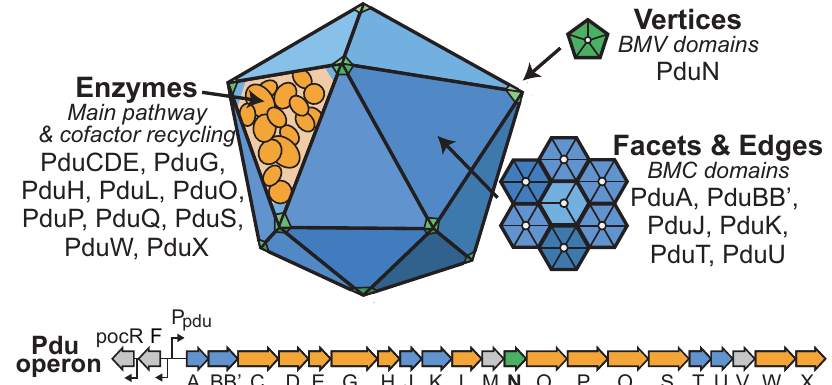
Fig. 1 The 1,2-propanediol utilization microcompartment from Salmonella is made up of proteins encoded by the pdu operon. The pdu operon in Salmonella enterica serovar Typhimurium LT2 contains the genes encoding proteins responsible for formation of the 1,2-propanediol utilization microcompartment (Pdu MCP). These include enzymes that perform both key pathway steps and cofactor recycling functions (orange) and shell proteins that encase these enzymes (bacterial microcompartment, BMC, domain-containing genes shown in blue, bacterial microcompartment vertex, BMV, domain-containing gene shown in green). Notably, only one shell protein in the pdu operon, PduN, contains a BMV